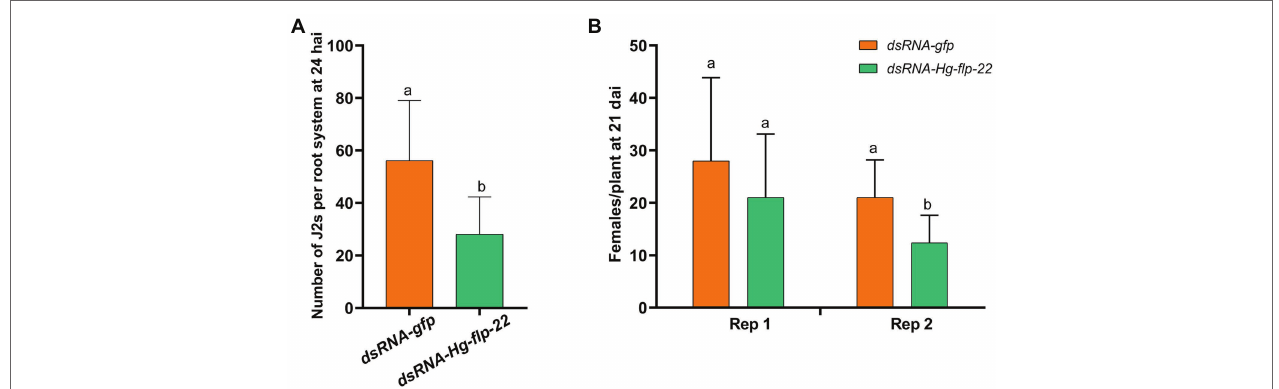
FIGURE 5 | Effect of in vitro RNAi of Hg-flp-22 on H. glycines infection and development in soil. (A) The penetration ability of Hg-flp-22 -silenced or gfp dsRNA- treated nematodes in soybean roots grown in pots containing sterilized sand and soil. Each plant was inoculated with 200 J2s. The number of nematodes in soybean roots was counted at 24 h after inoculation (hai) through acid fuchsin staining. Data are the means ± SD from eight plants and are representative of two independent experiments. The same letter denotes no significantly difference in the number of Hg-flp-22 dsRNA-treated J2s ( p > 0.05, Tukey’s HSD test) compared with that of nematodes soaked with gfp dsRNA. (B) Females in soybean roots were observed 21 days after inoculation (dai) in two independent experiments. Values are the means ± SD from eight plants. Bars with the same letter indicate no significant difference at p > 0.05 (Tukey’s HSD test). J2s treated with gfp dsRNA were used as the control.